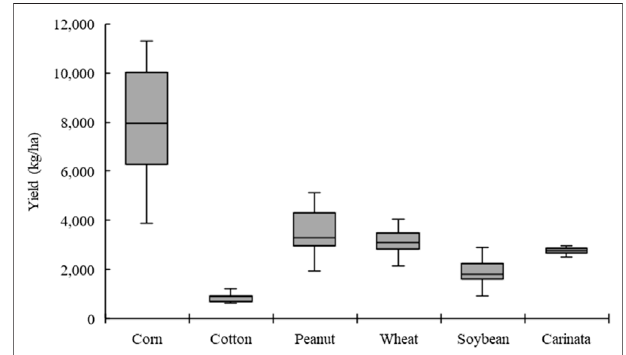
FIGURE 4 | Yield variability for different crops in South Georgia between 1988 and 2019. For carainata, simulated spatial yield variability across counties is used as a proxy for temporal variability.